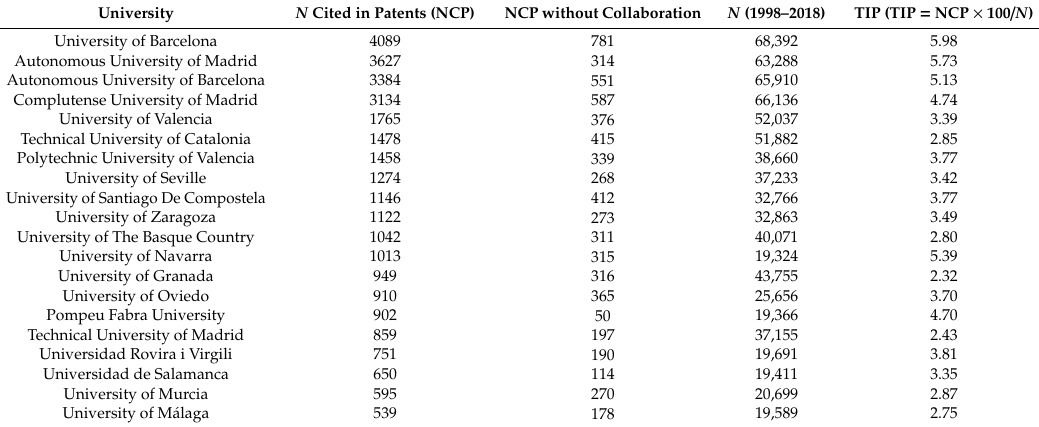
Table 2. Proposed Transference Index in Patents (TIP).